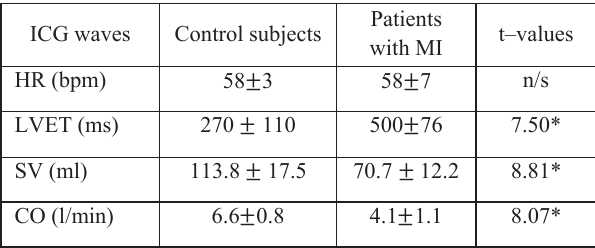
Note: HR: heart rate; LVET: left ventricle ejection time; SV: stroke volume; CO: cardiac output; * p<0.001: the differences are highly significant. n/s: not